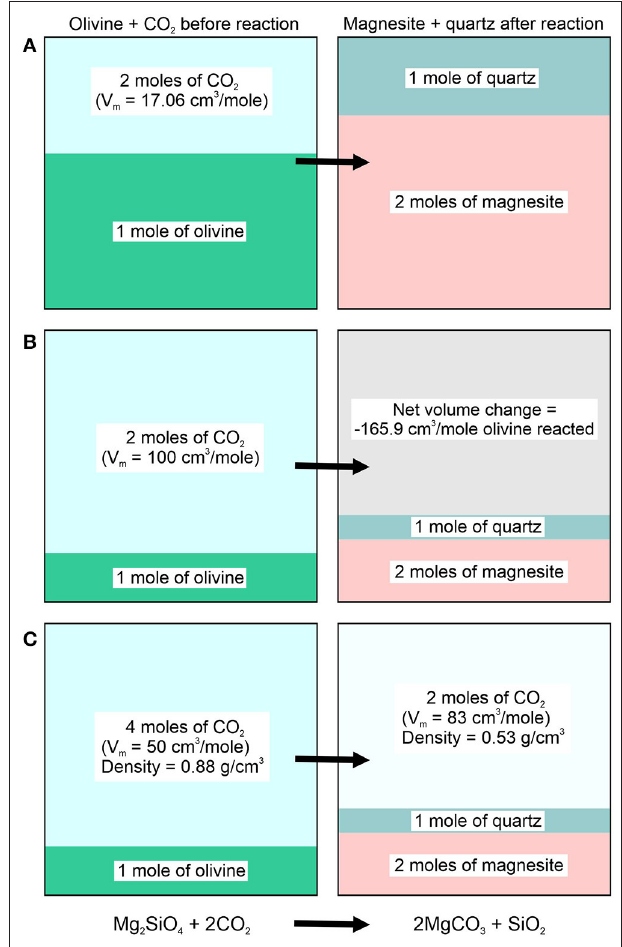
FIGURE 1 | Conceptual model showing the volume changes of different phases associated with the carbonation of olivine in a rigid, constant volume system: (A) In order for the reaction products magnesite and quartz to completely fill the volume occupied by olivine and CO 2 before the reaction begins requires that the CO 2 have a molar volume of 17.06 cm 3 /mole. In this case, all of the initial CO 2 and olivine react to form magnesite and quartz having the same total volume as that of the reactants. (B) If the molar volume of CO 2 before the reaction begins is 100 cm 3 /mole, conversion of all of the olivine to magnesite + quartz results in a negative net volume change for the reaction (void space). (C) If excess CO 2 is present before the reaction begins (i.e., the CO 2 /olivine molar ratio is > 2), the excess CO 2 will occupy the volume remaining after all of the olivine had been converted to magnesite and